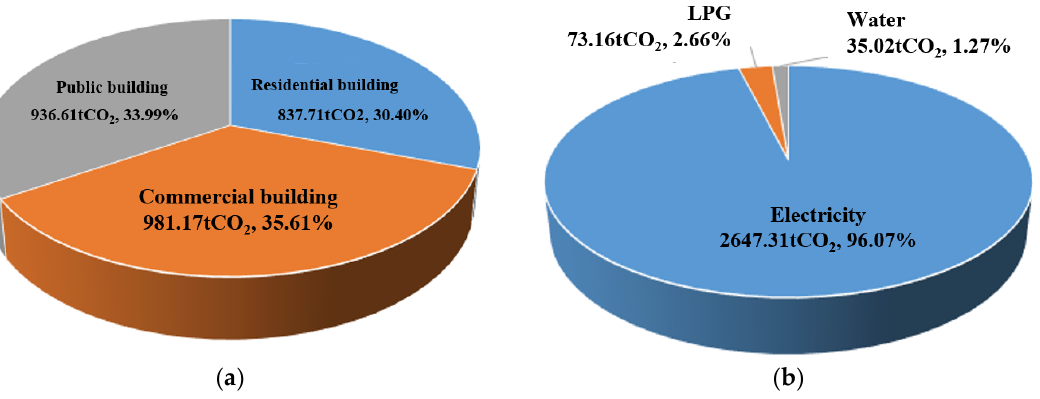
Figure 1. Statistics of building carbon emissions ( a ) and energy consumption ( b ) in village Y in